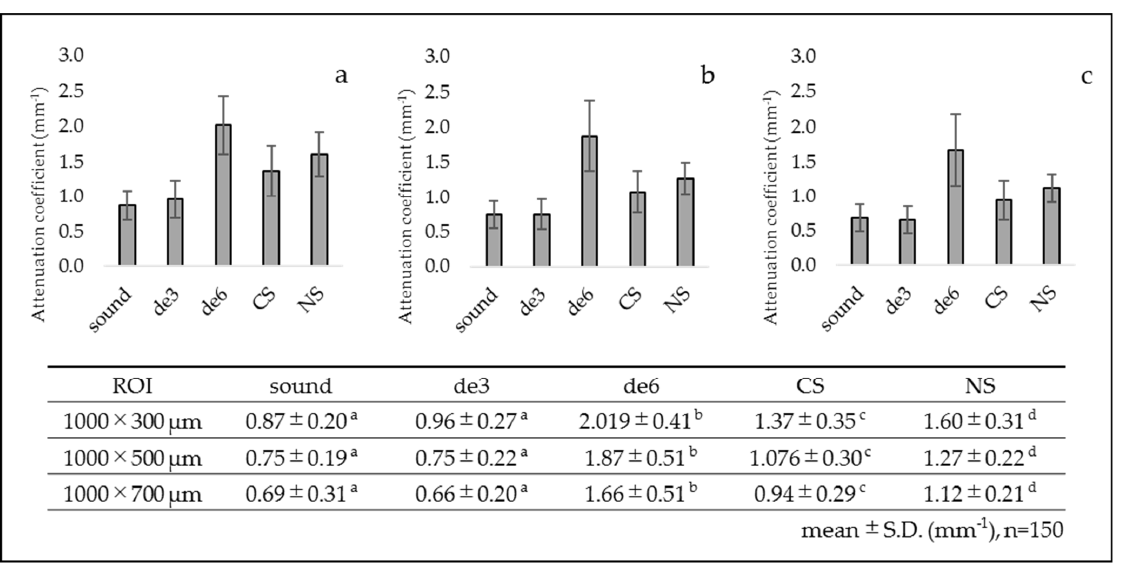
Figure 6. Integrated signal intensity in each ROI. CS and NS showed higher values than de6 for all the ROI depths ( p < 0.05). ( a ) ROI 1000 × 300 µm 2 , ( b ) ROI 1000 × 500 µm 2 , and ( c ) ROI 1000 × 700 µm 2 . The same lowercase letters indicate no